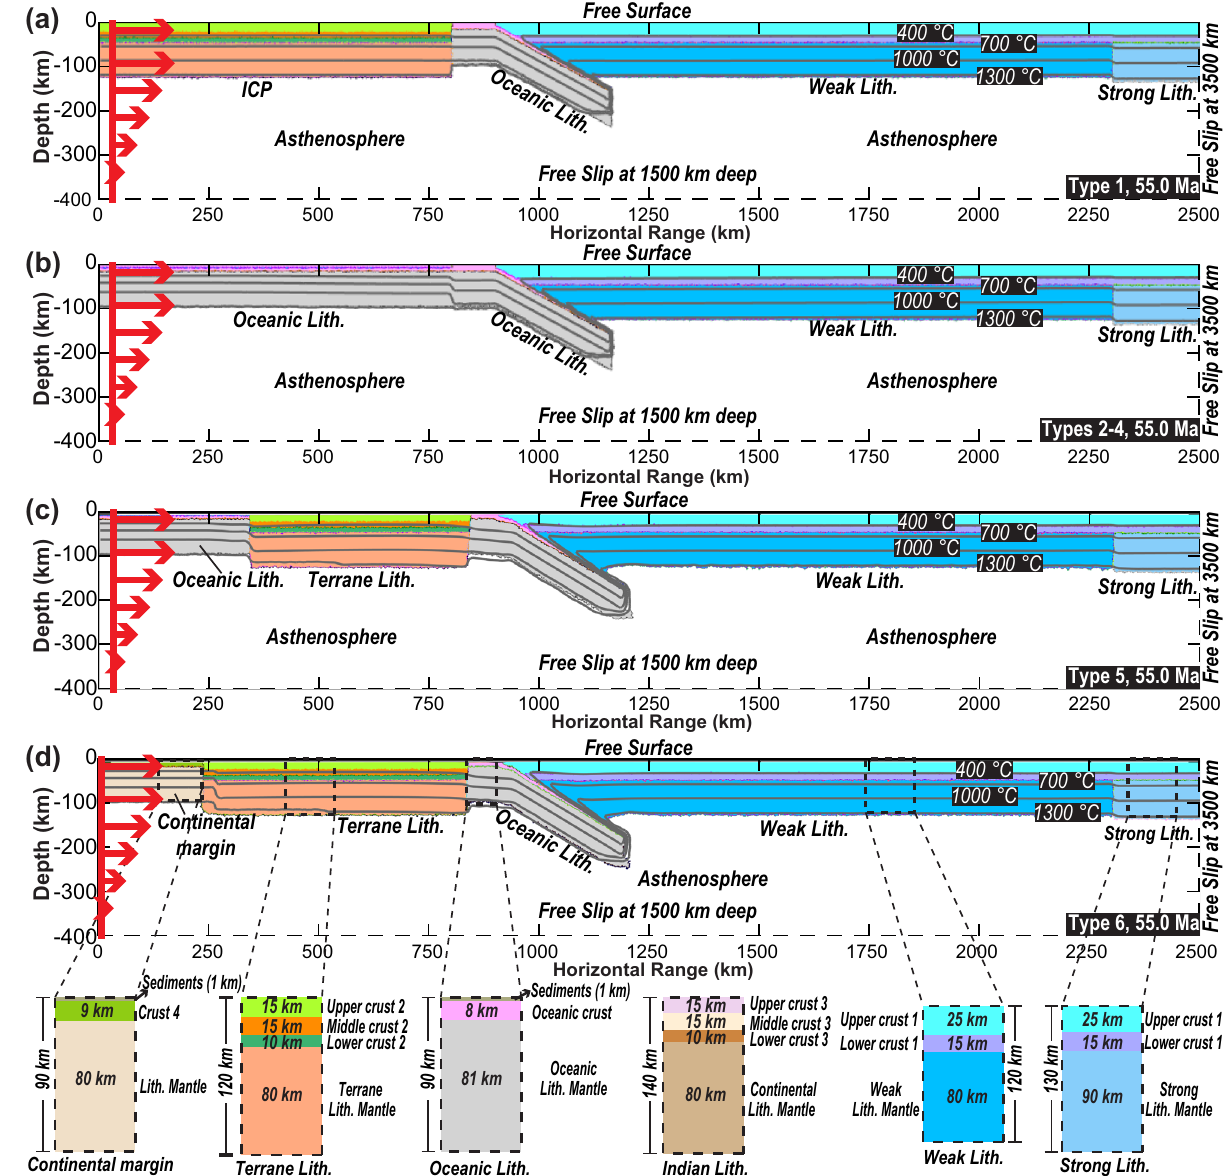
Fig. 3 | Initial and boundary conditions for the numerical models. a Type 1 models (Runs 1 – 4, Supplementary Figs. S5 and S6), where the incoming plate before the Indian Subcontinent indentation is purely continental. ICP-Incoming